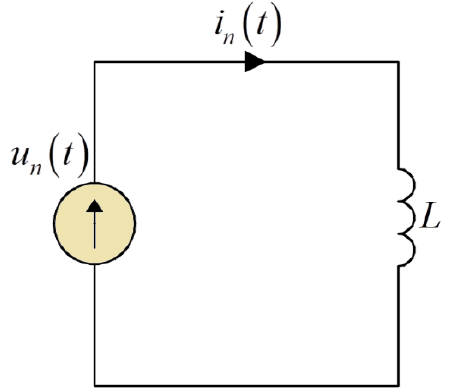
Figure 10. Scheme of the single-phase system used for theoretical calculations. Table 10. List of complex values of currents in CPC theory. Harmonic